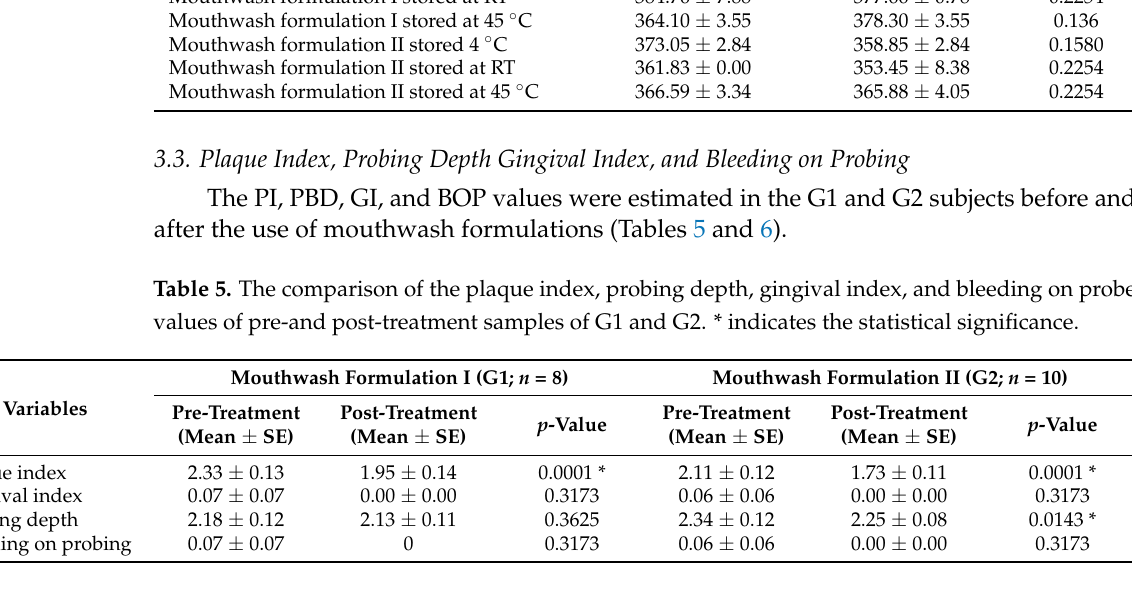
Table 6. The Mann–Whitney test compares the plaque index, probing depth, gingival index,